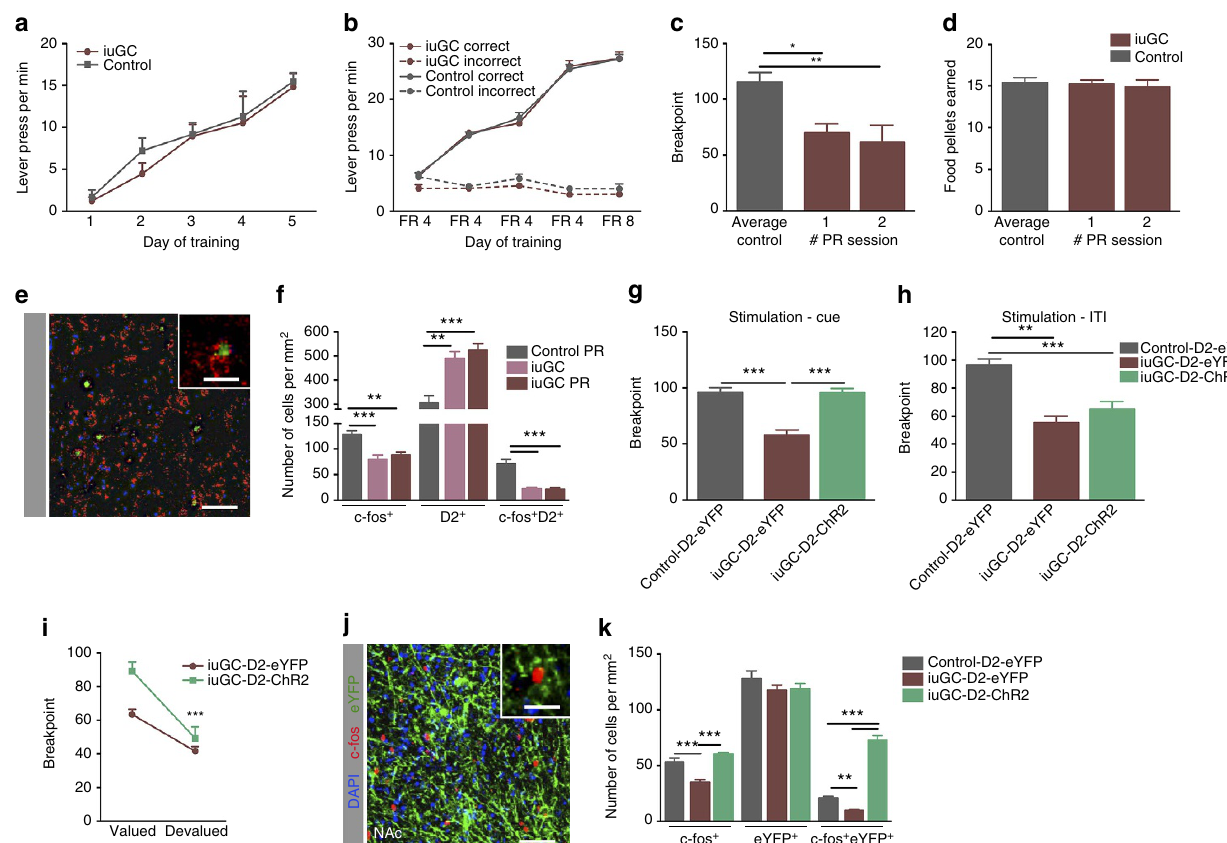
Figure 6 | NAc D2 neuronal activation rescues the behavioural deficits in a model of D2 dysfunction. ( a ) Continuous reinforcement (CRF) training sessions of the PR test shown as average number of lever presses per minute ( n ¼ 10). ( b ) Fixed ratio (FR) training sessions of the PR test are shown as average number of lever presses per minute. ( c ) iuGC rats have a lower breakpoint when compared with control animals; though the total number of food pellets earned in the PR test sessions is similar ( d ). ( e ) Representative image of double immunofluorescence for c-fos and D2 in the NAc; scale bar: 200 m m; inset: 40 m m. ( f ) iuGC animals present a reduction in the recruitment of D2 neurons (c-fos þ /D2 þ cells) ( n ¼ 6); iuGC animals present reduced total c-fos þ cells and increased D2 þ cells in the NAc, regardless of having performed the PR task or not. ( g ) D2 optogenetic stimulation during cue exposure normalizes iuGC breakpoint (iuGC-D2-ChR2 rats) (n control-D2-eYFP ¼ 11; n iuGC-D2-ChR2 ¼ 15; n iuGC-D2-eYFP ¼ 13). ( h ) When the optical stimulation was given during inter-trial interval (ITI), no effect in motivation was observed (n control-D2-eYFP ¼ 7; n iuGC-D2-ChR2 ¼ 7; n iuGC-D2-eYFP ¼ 5). ( i ) Breakpoint before and after food devaluation is depicted as average of absolute value; both groups decrease lever presses in devalued condition. ( j ) Representative image of immunofluorescence for c-fos and eYFP in the NAc of an animal that performed the PR task. Scale bar: 200 m m; inset: 40 m m. ( k ) Quantification of c-fos þ and eYFP þ cells in the NAc after PR performance with optogenetic stimulation shows that ChR2 neurons are being activated ( n ¼ 6); stimulated iuGC-D2-ChR2 animals present a substantial increase in the number of c-fos þ /eYFP þ cells in comparison to stimulated D2-eYFP animals. Error bars